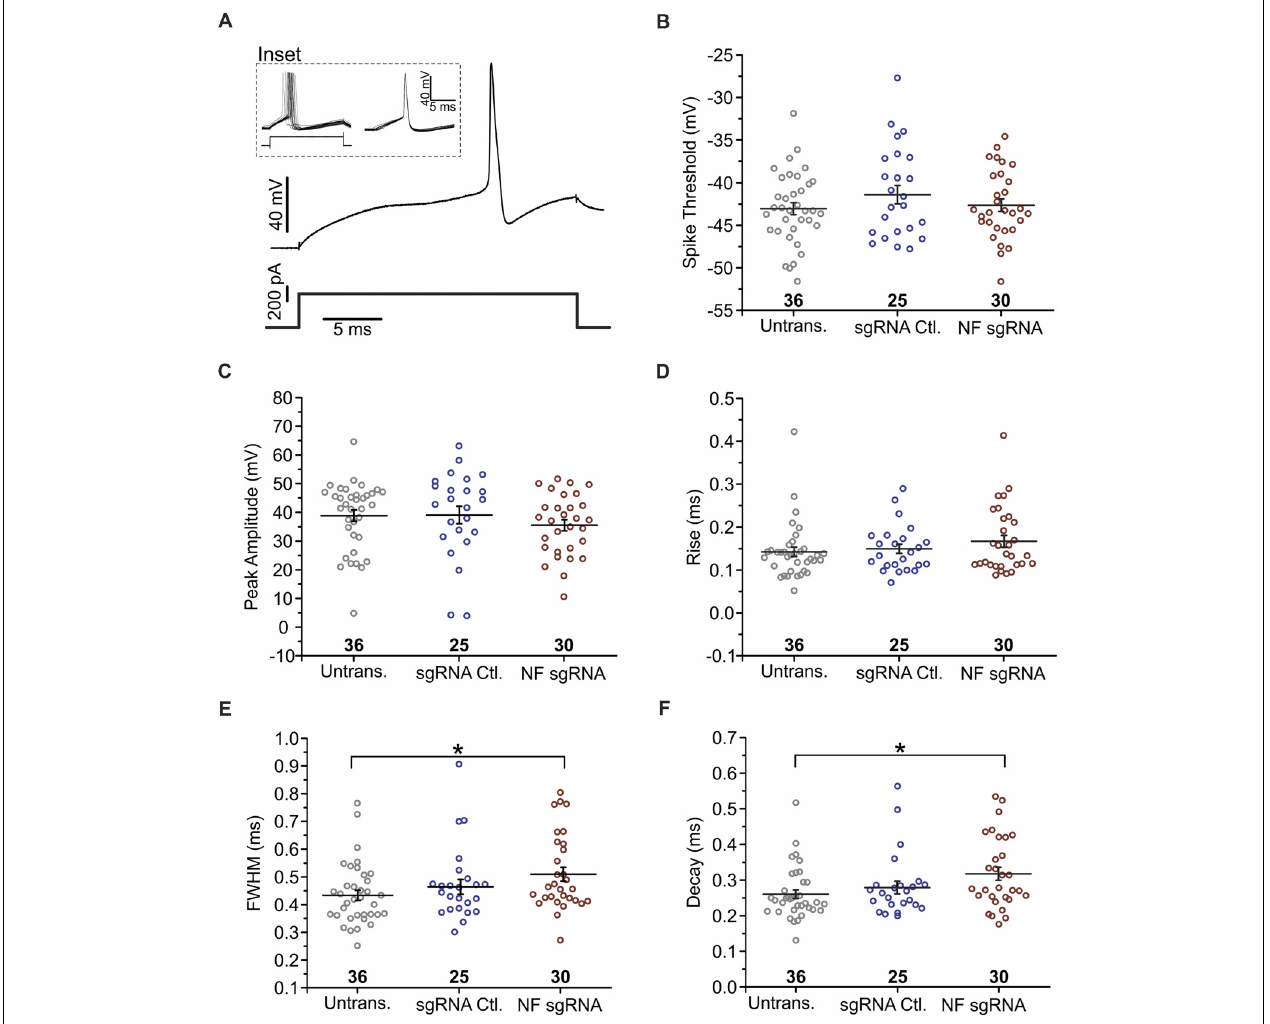
FIGURE 6 | Knockout of NF broadens action potentials. (A) Example of a single trace of the voltage change (top) in response to a current step (bottom). Inset shows voltage response to current step for 20 subsequent trials (left), which were then peak aligned (right) and averaged for analysis. (B) Measurements of spike threshold (Untransfected n = 36; sgRNA Ctl. n = 25; NF sgRNA n = 30). (C–F) Measurements of waveform parameters including peak amplitude ( C : Untransfected n = 36; sgRNA Ctl. n = 25; NF sgRNA n = 30), rise time ( D : Untransfected n = 36; sgRNA Ctl. n = 25; NF sgRNA n = 30), full-width at half maximum amplitude (FWHM; E : Untransfected n = 36; sgRNA Ctl. n = 25; NF sgRNA n = 30; ∗ p < 0.05, ANOVA with Tukey’s post hoc comparisons), and decay time ( F : Untransfected n = 36; sgRNA Ctl. n = 25; NF sgRNA n = 30; ∗ p < 0.05, ANOVA with Tukey’s post hoc comparisons). Error bars indicate mean ±